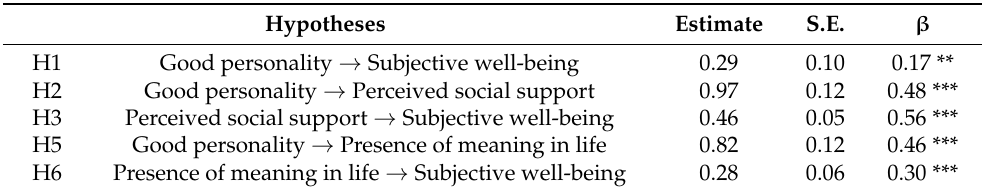
Table 6. SEM Results for Model